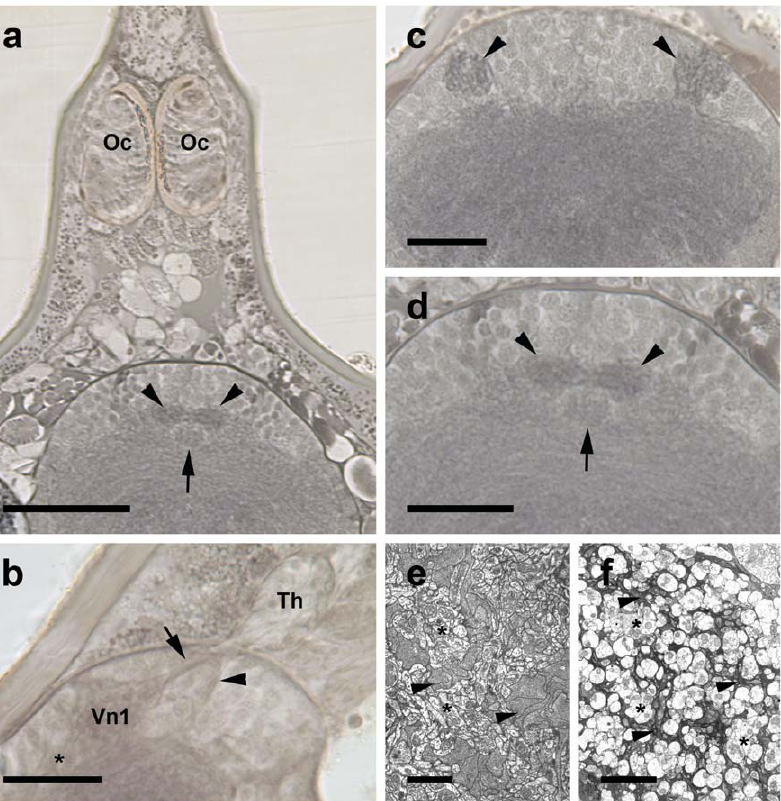
Figure 2. Anatomy of the visual neuropils (a–d, Wigglesworth stains, Acheliavulgaris ; e, f TEM, Endeisspinosa ). Note dark stain of sensory neuropils after application of Wigglesworth’s technique. a , Eye tubercle with two ocelli (Oc) and protocerebrum with left and right second visual neuropils (arrowheads) and arcuate body (arrow), transversal section. Bar 50 m m. b , Thickening (Th) distal to protocerebral cell body rind, first visual neuropil (Vn1), bifurcation of visual tract into a subset of fibres projecting to first (arrow) and second neuropil (arrowhead), respectively, and tract connecting first visual neuropil with protocerebrum (asterisk), sagittal section. Bar 25 m m. c , First visual neuropils (arrowheads) dorsolaterally in rostral part of protocerebrum, transversal section. Bar 25 m m. d , Second visual neuropils (arrowheads) deeper in protocerebrum in a more rostral and central position, and arcuate body (arrow), transversal section. Bar 25 m m. e , f , Frontal section of distal ( e ) and ( f ) of proximal region of first visual neuropil showing arrangement of retinula axon terminals (arrowheads) and dendrites and cell bodies of visual second order neurons (asterisks). Note that in distal region ( e ) retinula axons are broad; in proximal region ( f ) they are narrow. Bars 5 m m.